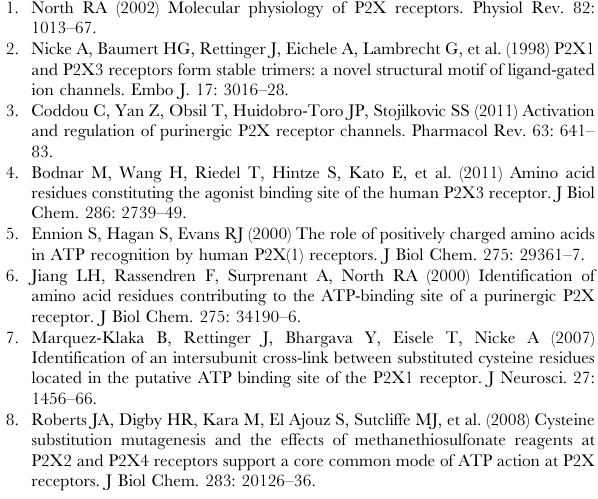
represented in blue and gray. Table S1 Characterization of the DF and LF alanine mutants of rP2X4R. Table S2 Desensitization parameters for the DF and LF mutants of the